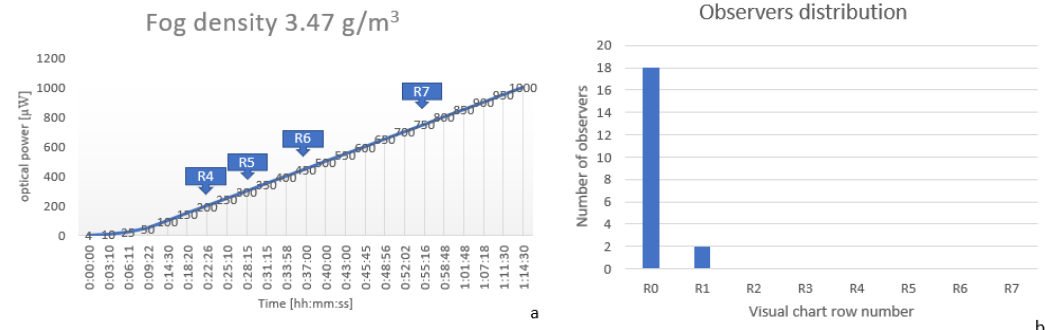
Figure 12. ( a ) Optical power and OCR measurements at a fog density of 3.47g/m 3 ( b ) Observers visual acuity distribution at a fog density of 3.47g/m 3 .